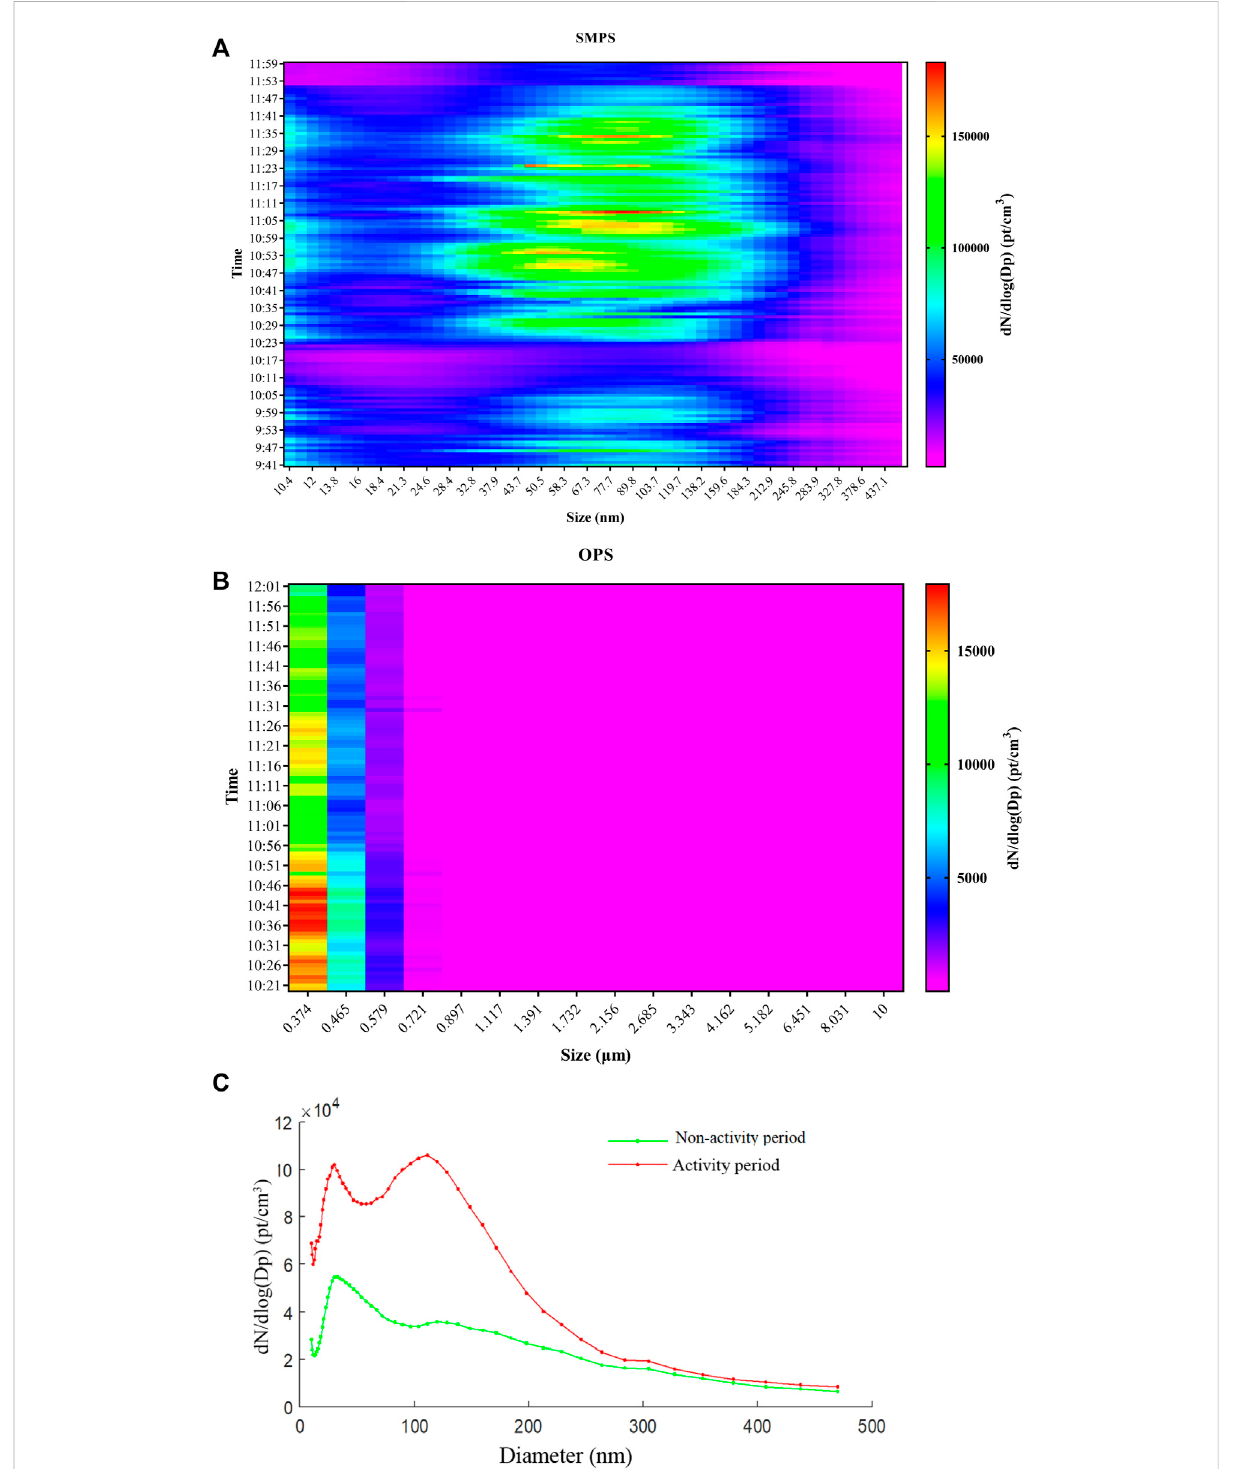
FIGURE 3 Temporal variations of particle size distribution by number. (A) Real-time particle size spectrum of scanning mobility particle sizer (SMPS); (B) Real-time particle size spectrum of optical particle sizer (OPS); (C) The temporal variations in mode size of